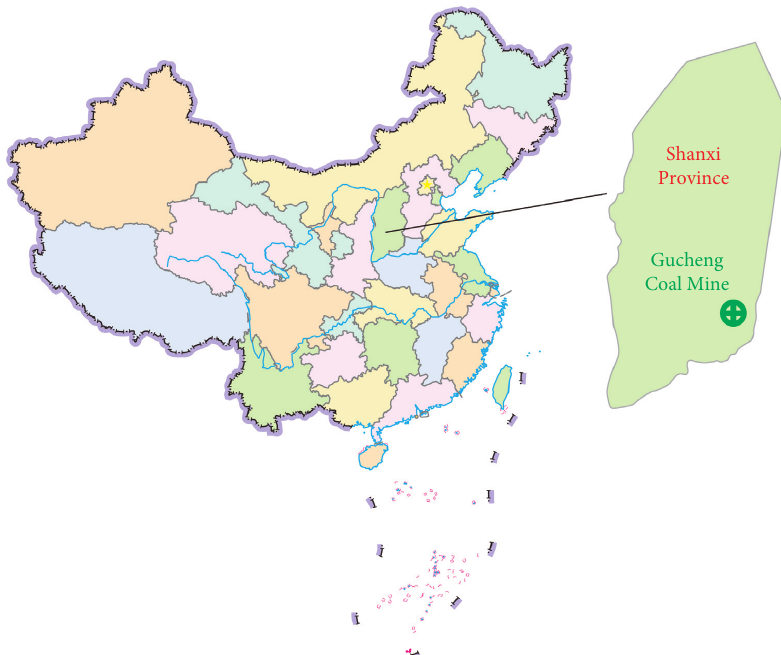
Figure 22: Geographical location of Gucheng Mine.